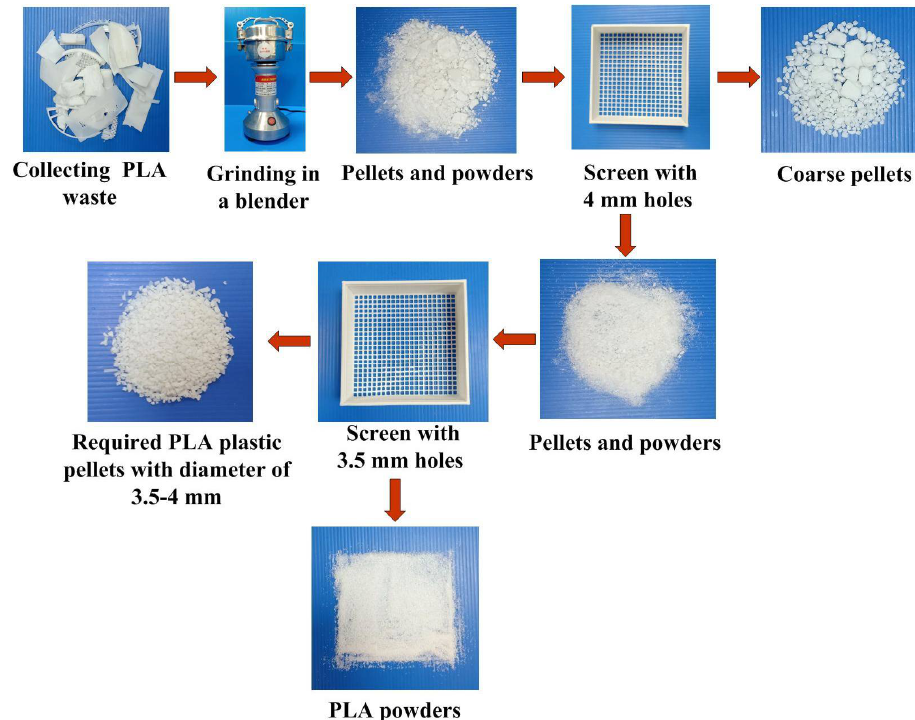
Figure 1. Process workflow for making recycled PLA pellets.